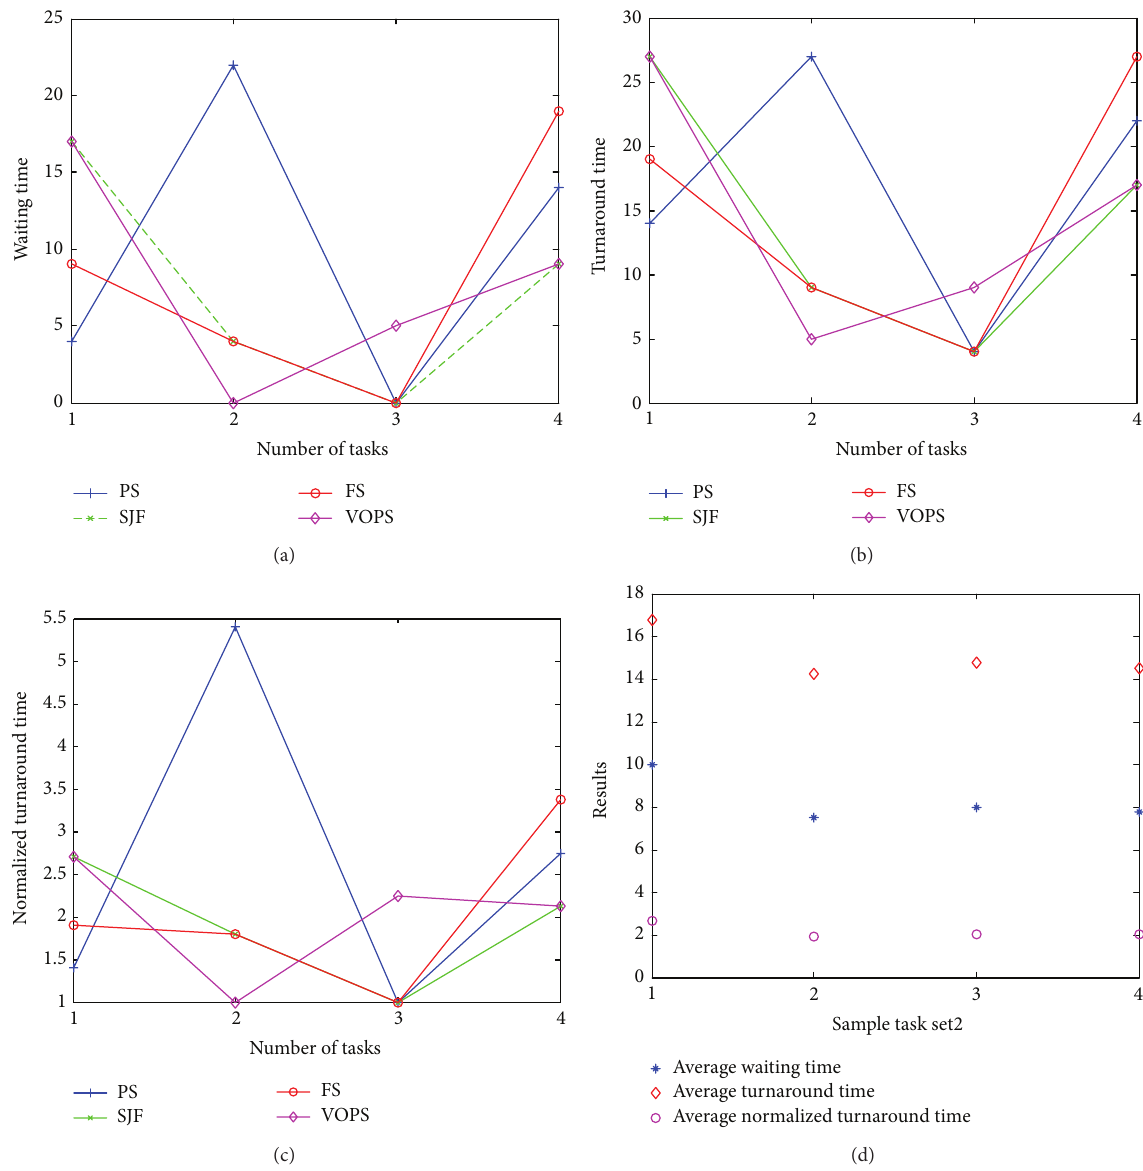
Figure 8: (a) Waiting time for sample task set 2. (b) Turnaround time for sample task set 2. (c) Normalized turnaround time for sample task set 1. (d) Results of sample task